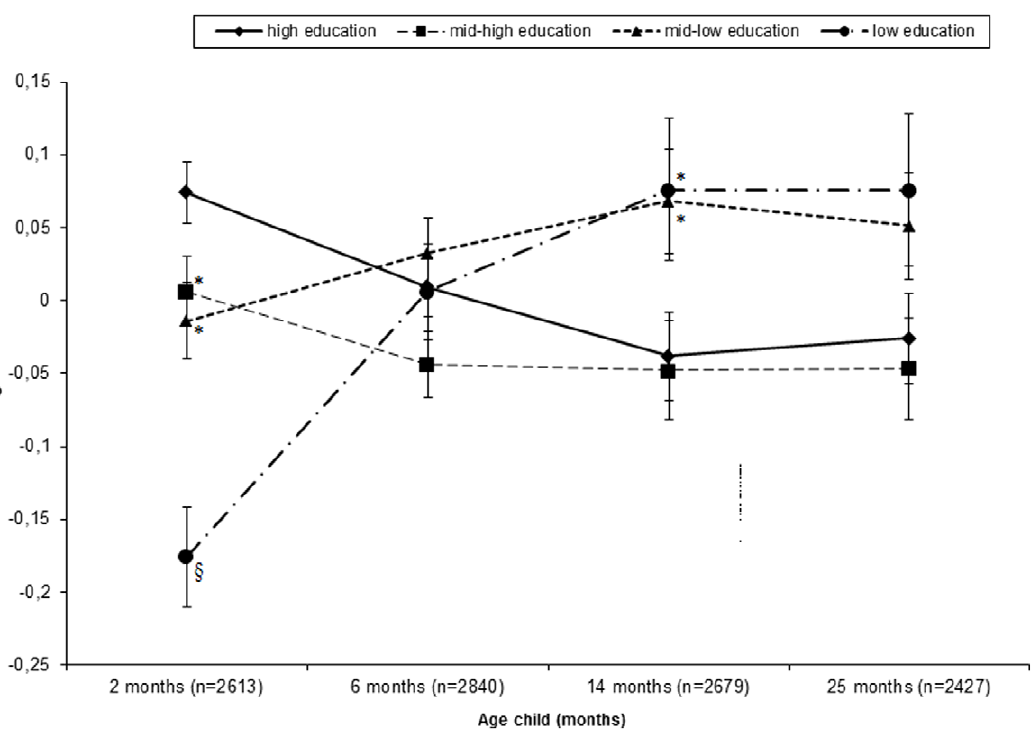
Figure 2. Internally derived SDS + / 2 standard errors for height, stratified by maternal educational level. All Values adjusted for the child’s age at measurement. * Significantly different from height SDS in the high-education subgroup at level p , 0.001. 1 Significantly different from height SDS in the high-education subgroup at level p , 0.05.